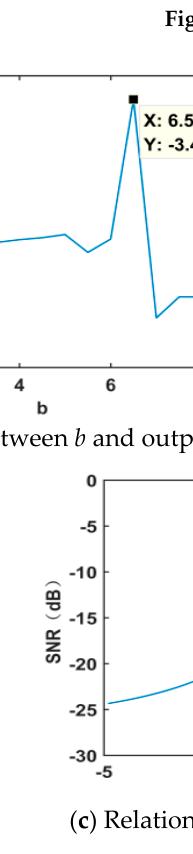
Figure 5. Relationship between system parameters and output SNR.